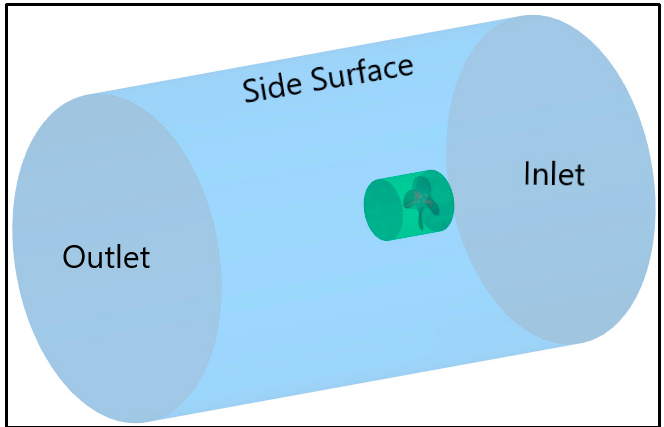
Figure 2. The computational domain used in the numerical calculations.